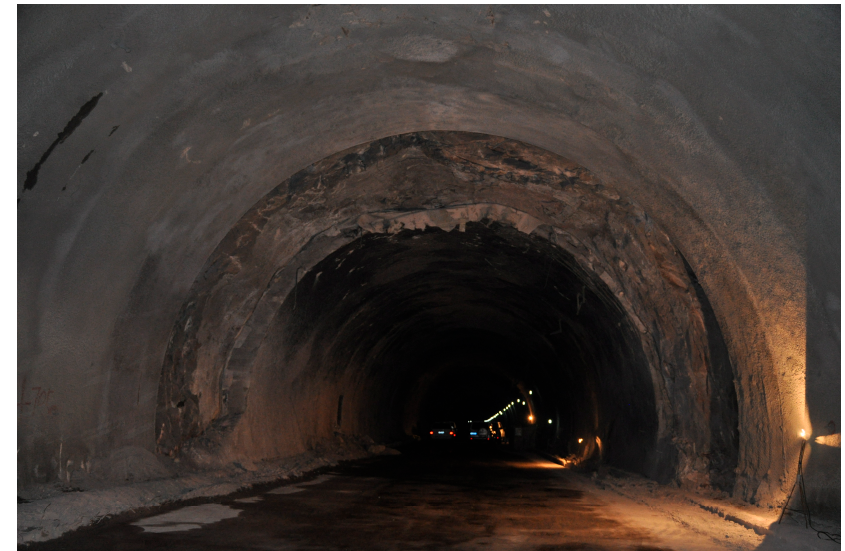
Figure 2. Lining of New Qidaoliang Tunnel after the fire.